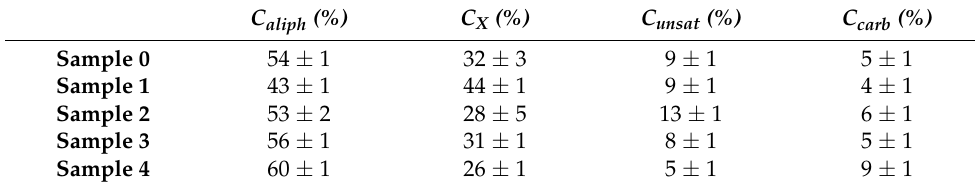
Figure 2. ( a ) HR-MAS 13 C–{ 1 H} NMR spectrum of Sample 0 (in blue) compared with CP-MAS 13 C NMR spectrum of OFMSW sample reported in the literature (in black) [26]; ( b ) HR-MAS 13 C NMR spectrum of Sample 0 and signal assignment. In the box, the comparison with the CP-MAS spectrum of starch in the same region is shown [31]. Table 2. Integral values, in percentage, of different carbon type, aliphatic ( C aliph ), heteroatoms-linked ( C X ), unsaturated ( C unsat ) and carbonylic ( C carb ), calculated for the Samples 0, 1, 2, 3, and 4 at 12